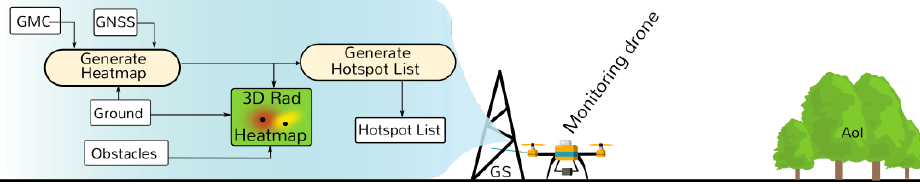
Figure 5. Monitoring phase—post-processing: from GMC samples to Heatmap and Hotspot list.